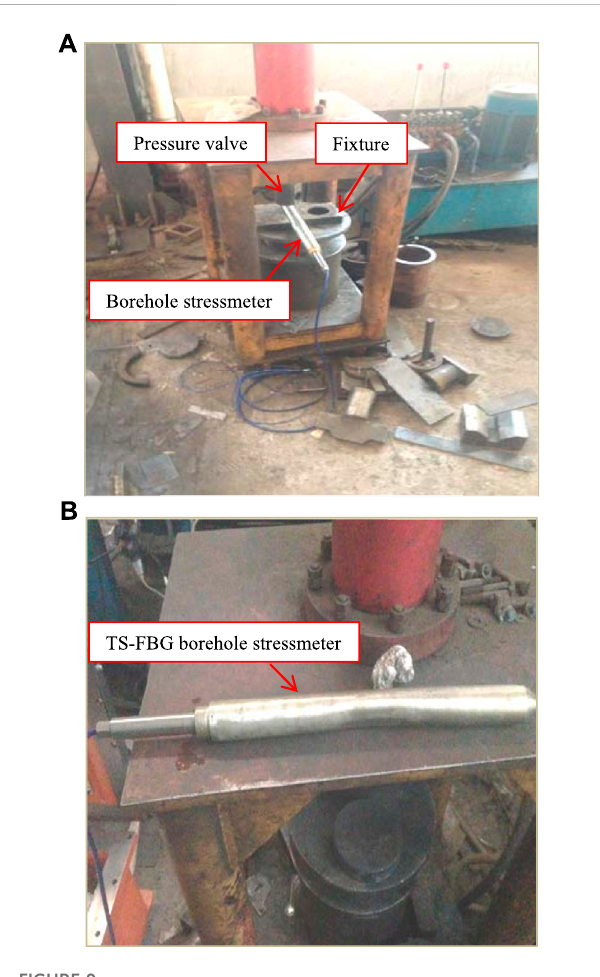
FIGURE 9 Before and after the performance test of the TS-FBG borehole stress meter. (A) Before the test. (B) After the